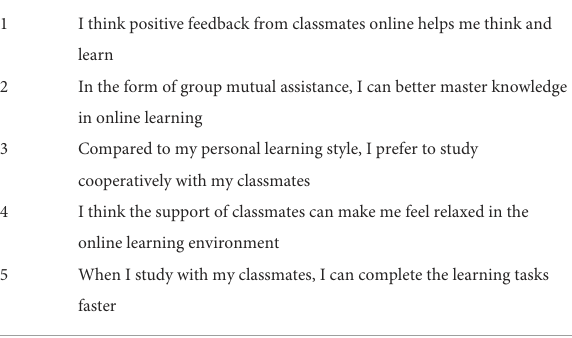
TABLE 5 Positive academic emotion scale.